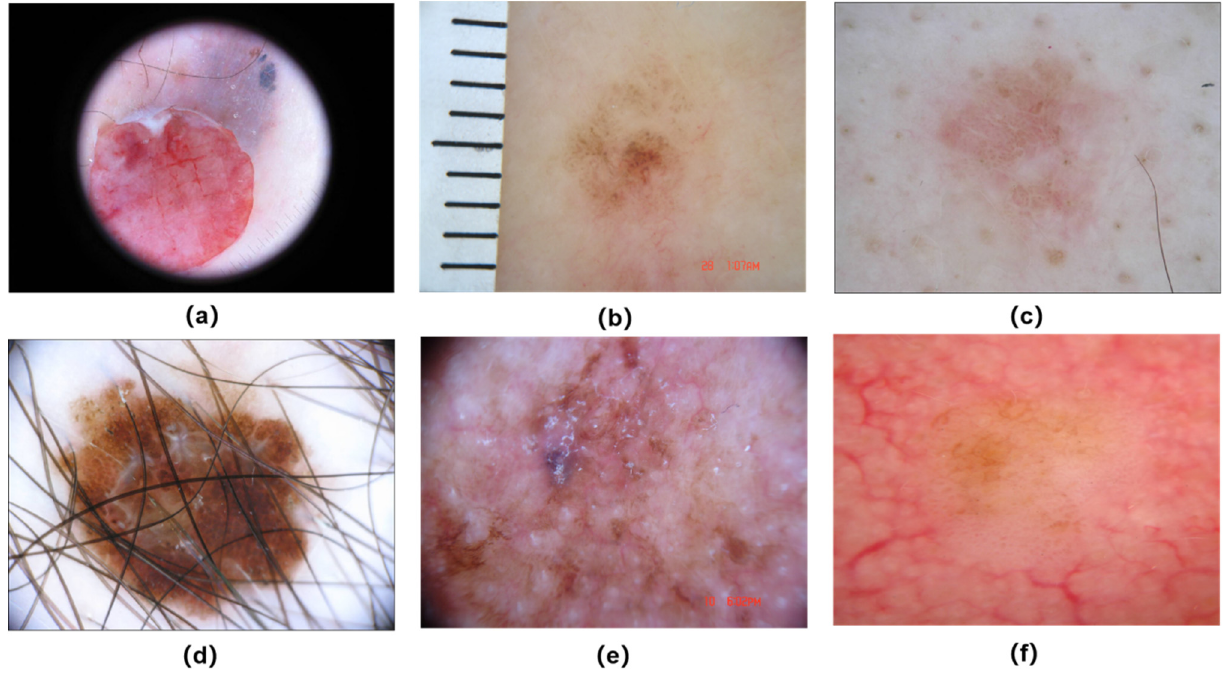
Figure 1. The challenges of automatic skin lesion segmentation from dermoscopy images: ( a ) black frame; ( b ) mark artefact; ( c ) low contrast; ( d ) hair artefact; ( e ) bubbles; ( f ) blood vessels.